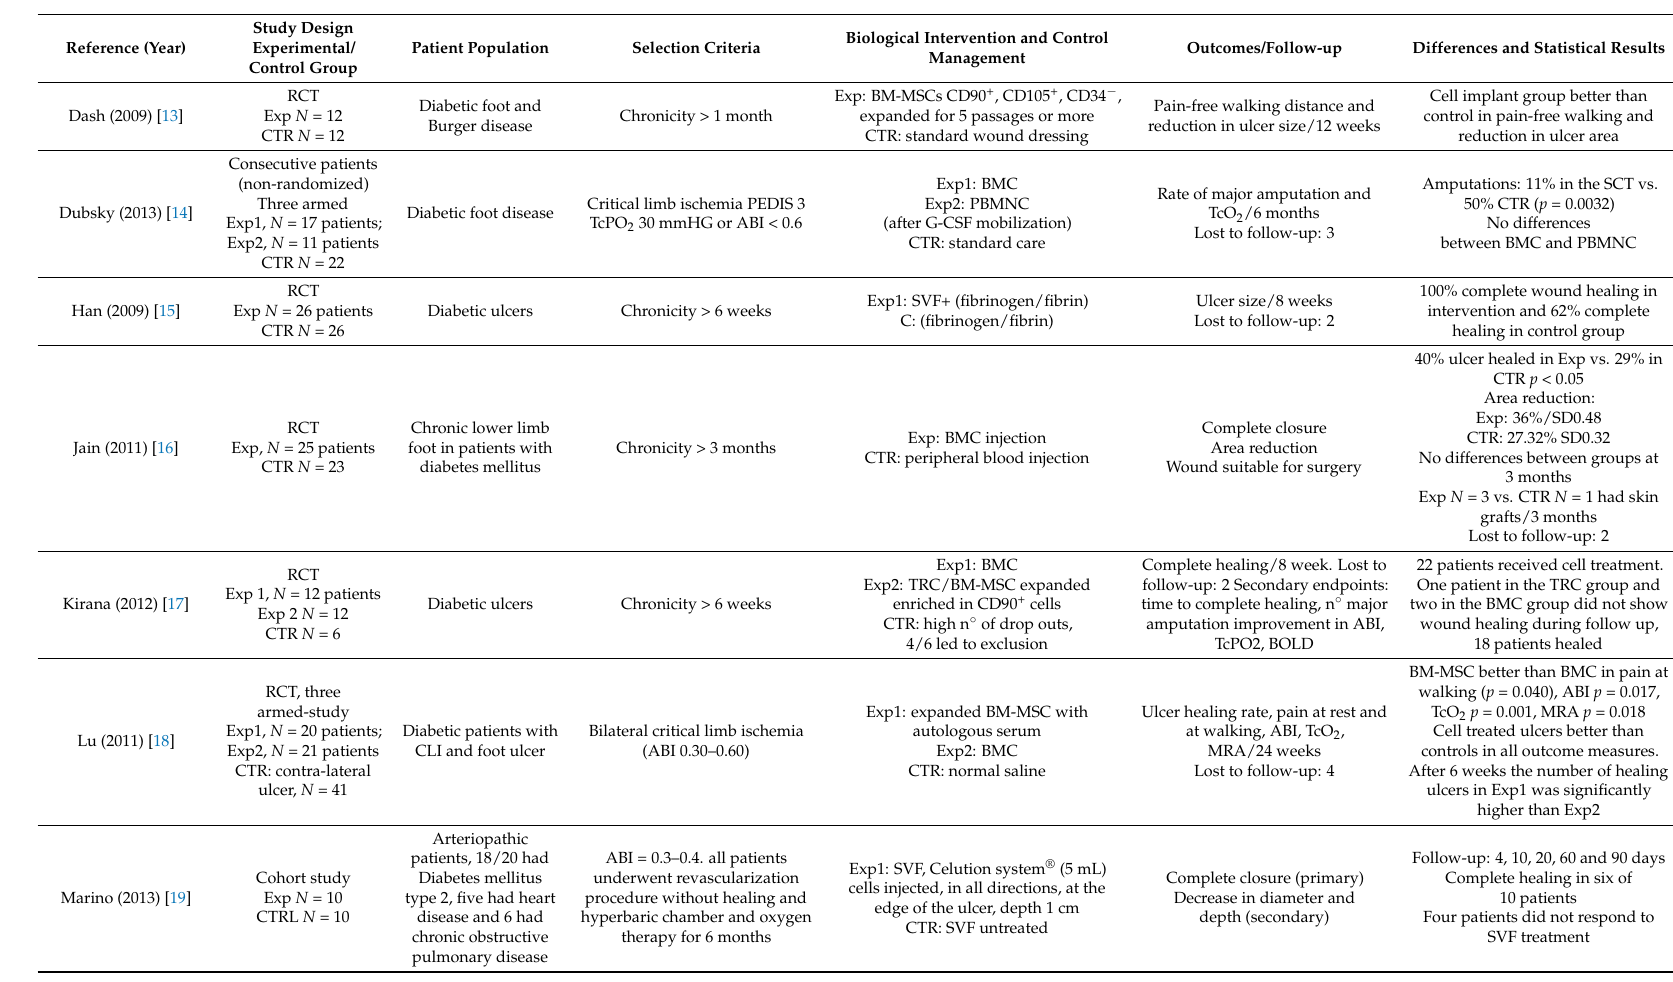
Table 1. Summary of included